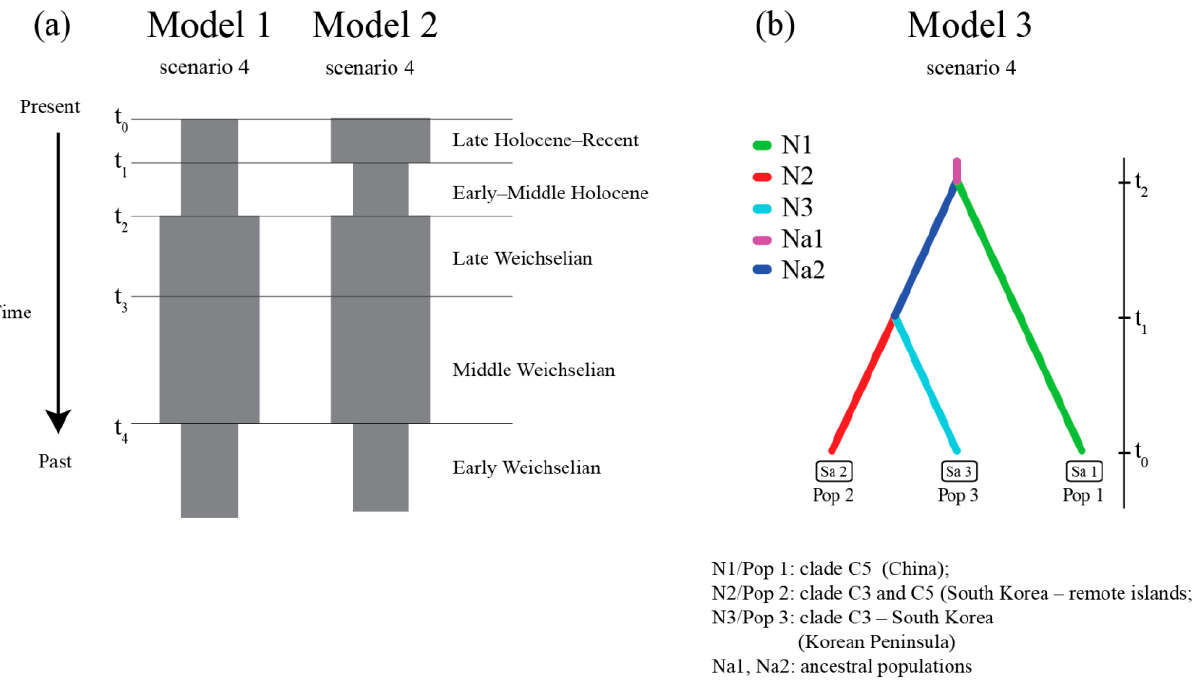
Figure 6. Representation of the most probable demographic scenarios for clades C1 and C3 (Model 1 and 2) ( a ) and evolutionary scenario of divergence the Korean population of A. agrarius (Model 3) ( b ) analyzed with the ABC method implemented in DIYABC.